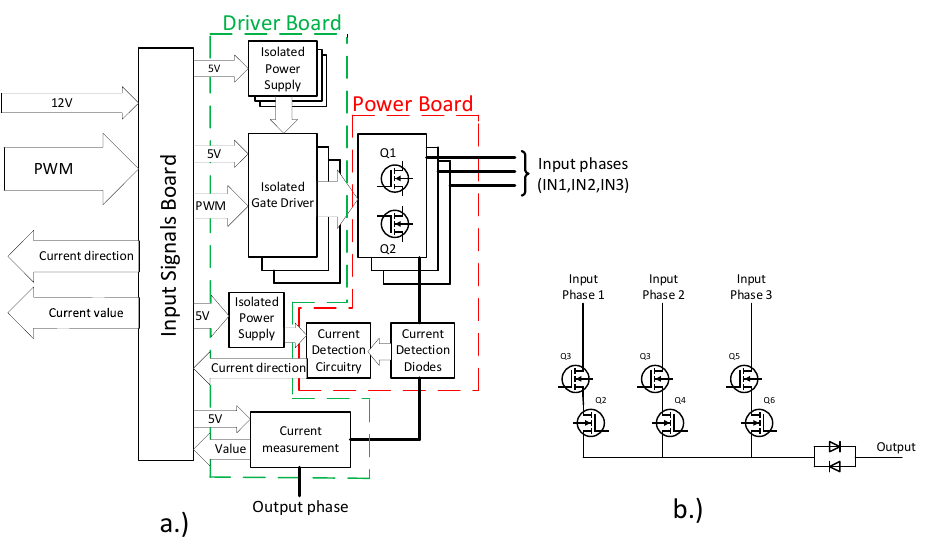
Figure 3. ( a ) Block diagram of the presented module, ( b ) schematic of the power part of the pre- sented module.